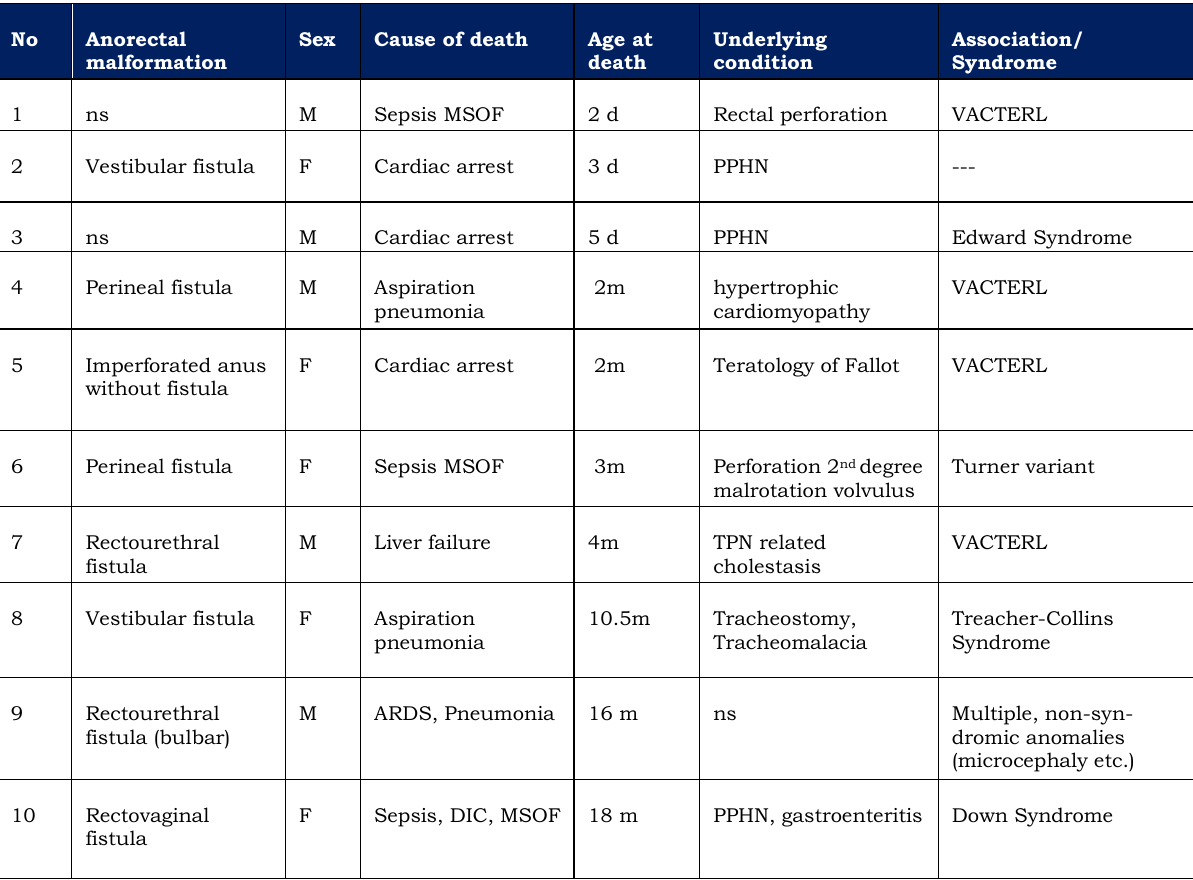
Table 5: Mortality Analysis